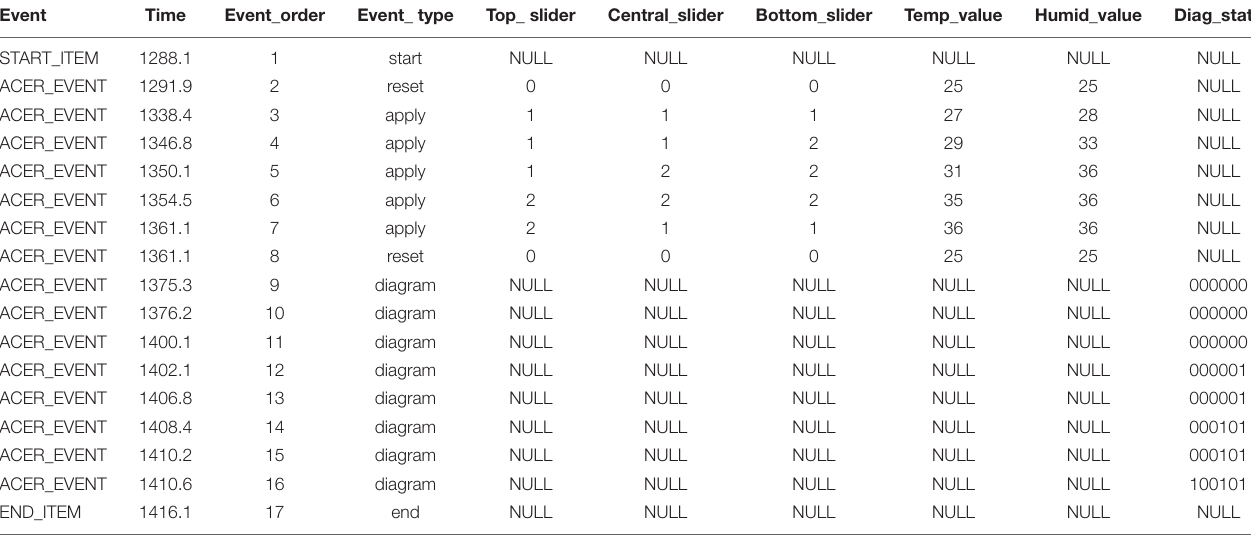
TABLE 2 | An example of process data for a test taker solving the climate control